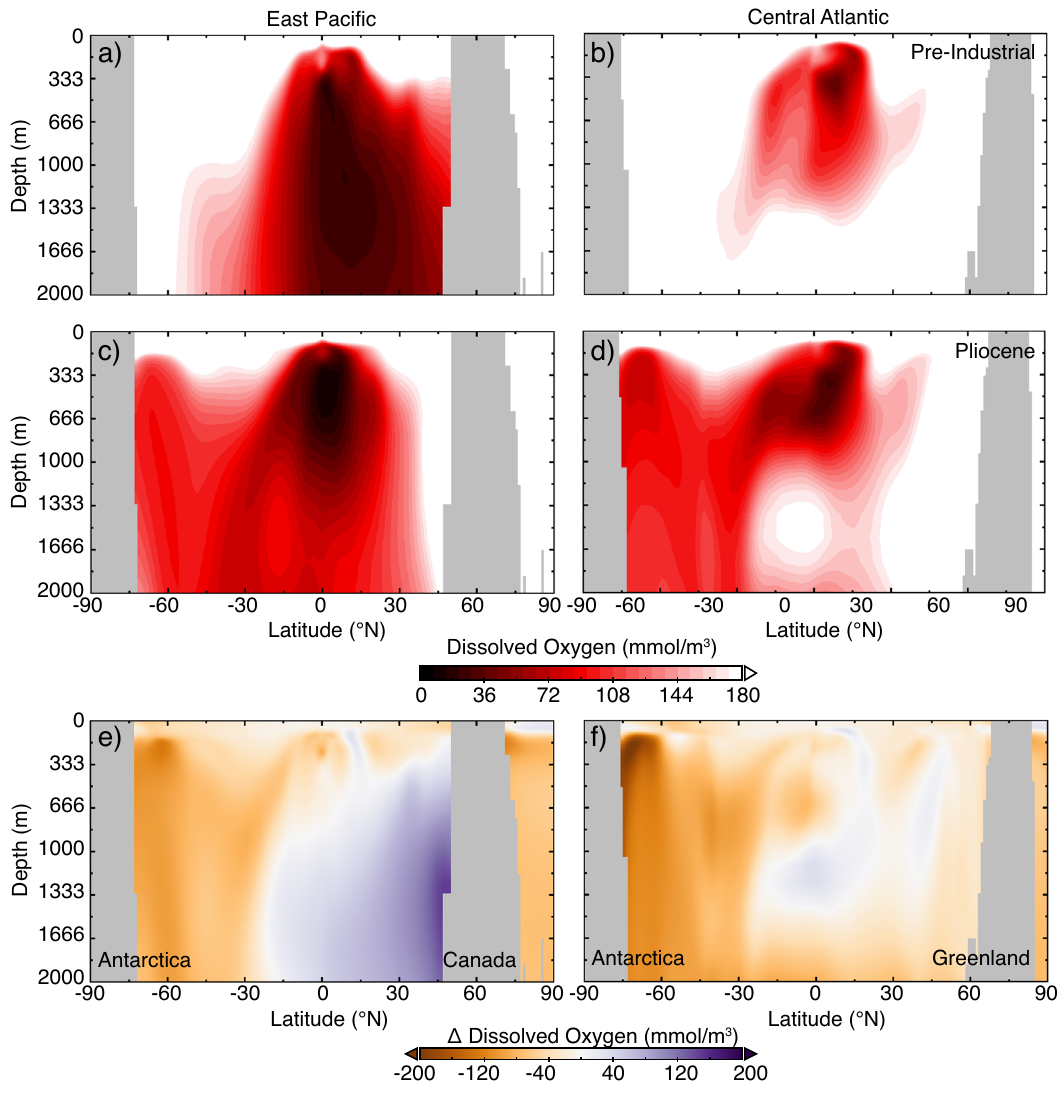
Fig. 5| Comparison ofoxygenin sectionsfromPre-Industrialand Pliocene-like simulations. Transects through the East Paci fi c (130°W) ( a , c , e ) and Central Atlantic (30°W) ( b , d , f ) with outputs from the Pre-Industrial control (a, b) and Pliocene-like simulation ( c , d ), and the difference in oxygenation between the